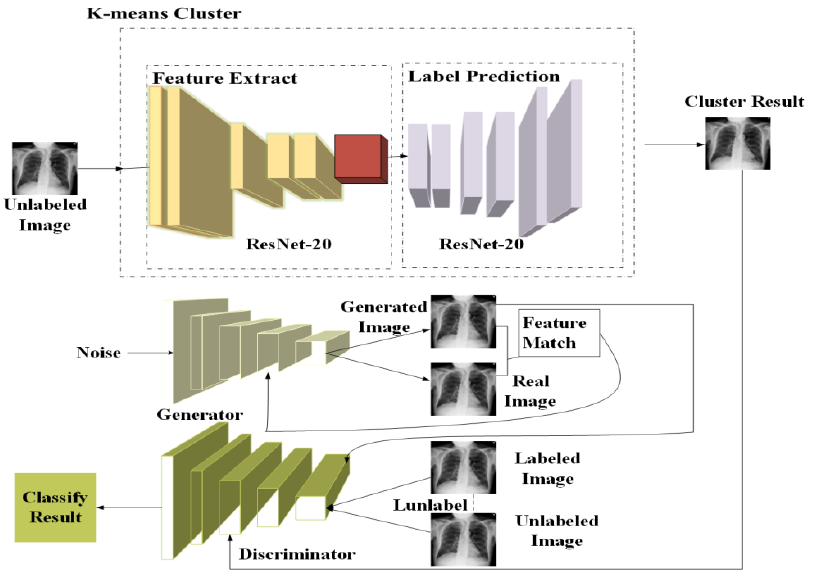
Figure 1. Overiew of the proposed pseudo-labelling-based semi-supervised generative adversarial network (PLAB-GAN). network